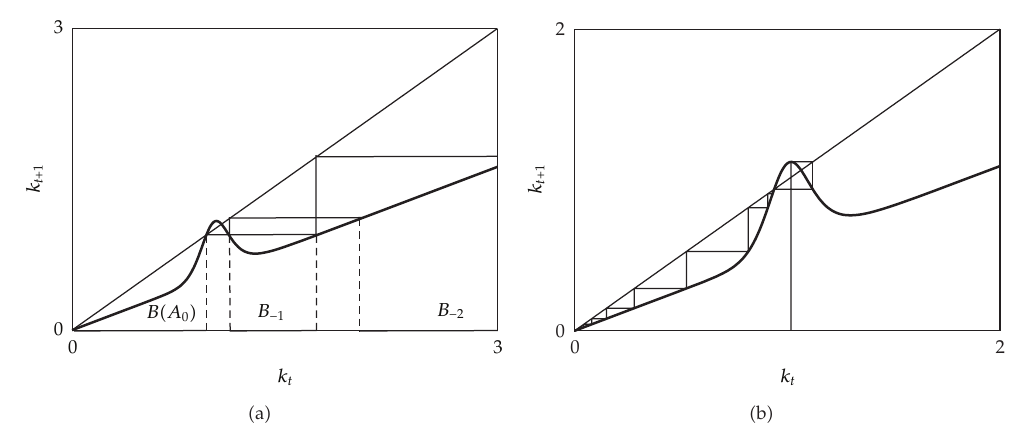
Figure 6: (cid:3) a (cid:6) Unconnected basin of attraction of the origin for the following parameter values: β (cid:7) 0 . 9, s w (cid:7) 0 . 1, s r (cid:7) 0 . 7, p (cid:7) 15, δ (cid:7) 0 . 2, n (cid:7) 0 . 5, and α (cid:7) 0 . 32. (cid:3) b (cid:6) After the final bifurcation the origin attracts the trajectory starting from the maximum point for α (cid:7) 0 . 34.